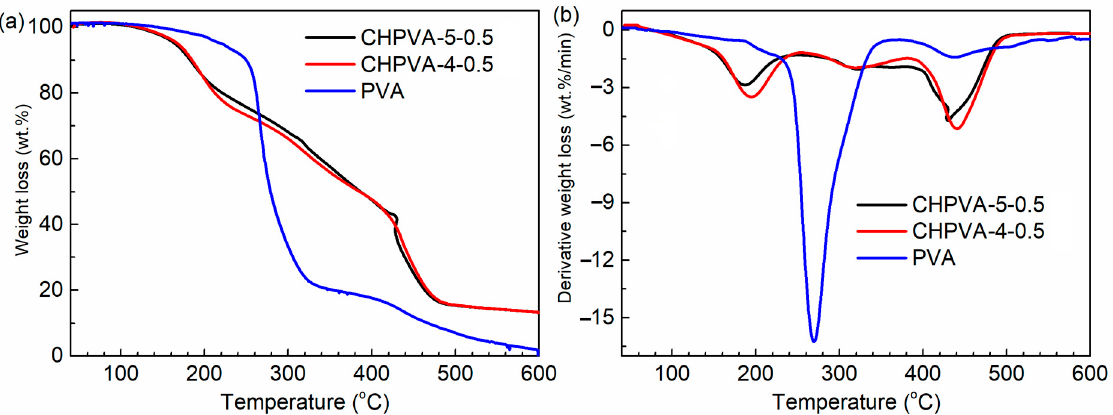
Figure 4. ( a ) TGA curves for PVA and CHPVA gels; ( b ) DTG curves for PVA and CHPVA gels (heating rate 10 °C/min).